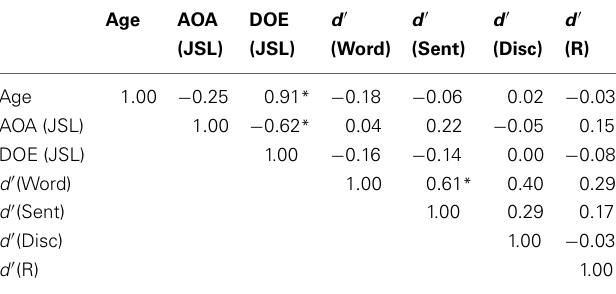
Table 3 | Correlation matrix of participants’ profiles and behavioral